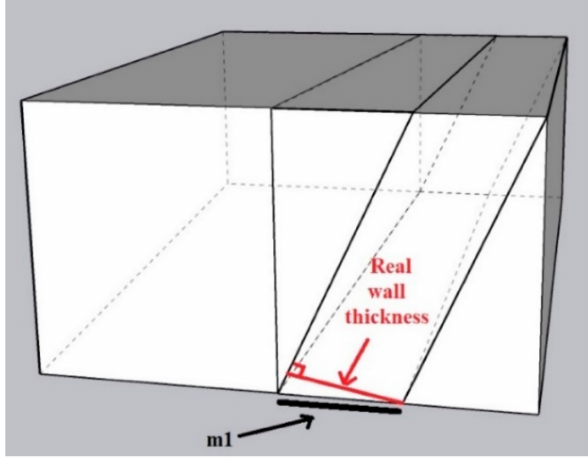
Figure 13. Difference between the real wall thickness and